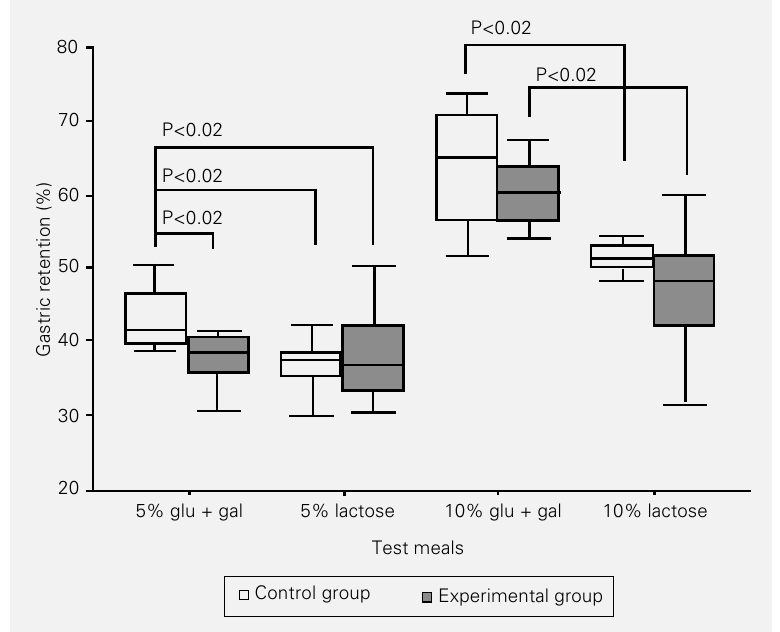
Figure 1 - Gastric retention (%) 15 min after the infusion of test meals containing 2.5% glucose + 2.5% galactose (5% glu + gal), 5% lactose, 5% glucose + 5% galactose (10% glu + gal) or 10% lactose. The rats were fed normal chow (control) or chow with 20% (w/w) lactose (experimental) for four weeks after which time the gastric retention was measured (N = 12 per subgroup). The data are presented as box plots, where the intermediate, lower and upper horizontal lines indicate the median, first and third quartiles of the gastric retention values, respectively, and error bars indicate the maximum and minimum gastric retention values observed. Significant differences between subgroups tested by the Kruskal- Wallis test (P<0.10) followed by the multiple comparisons test (P<0.02) are indicated in the